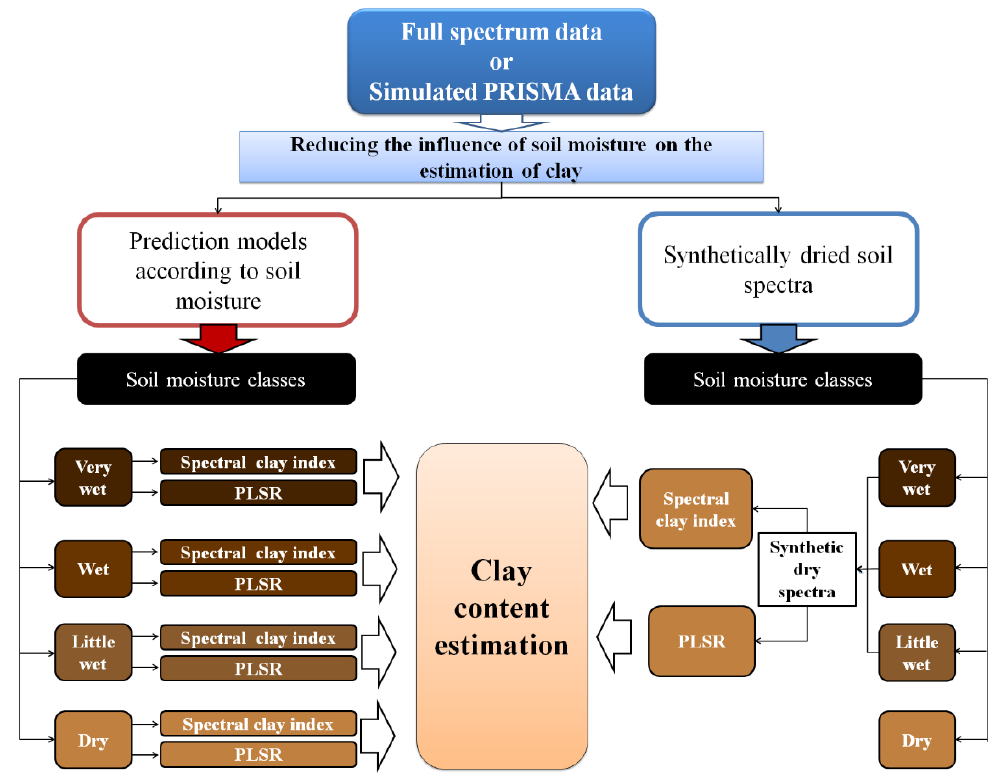
Figure 1. Flow chart concerning the estimation of clay estimation using different prediction models according to soil moisture content or using reconstructed (synthetically) dry soil